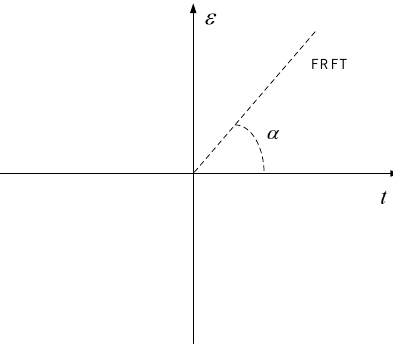
Figure 5. Transform domain of fractional Fourier